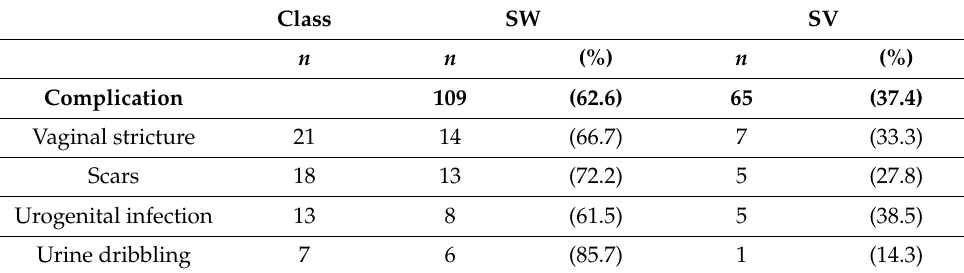
Table 4. Overview of the most common complications according to CAH-classes.